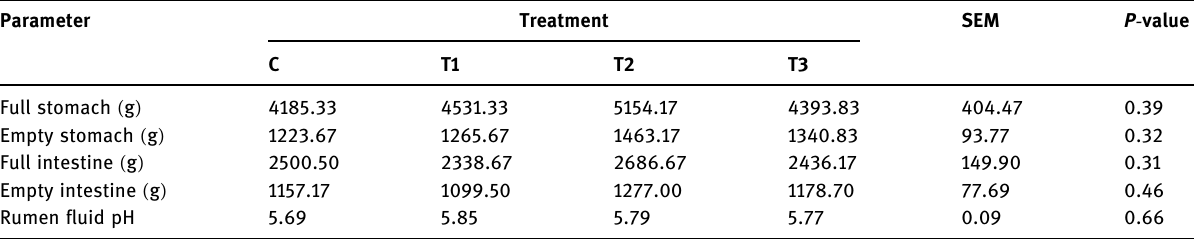
Table 8: Digestive system and fi nal rumen fl uid pH of DFM - o ff ered growing Najdi lambs weaned at di ff erent ages